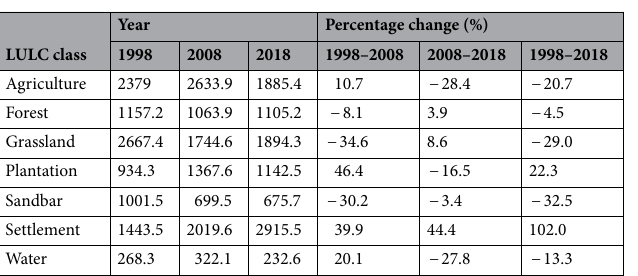
Table 1. Area information and change of the LULC classes in the study area (sq. km) during 1988, 2008 and 2018. *Negative (−) sign indicates percentage